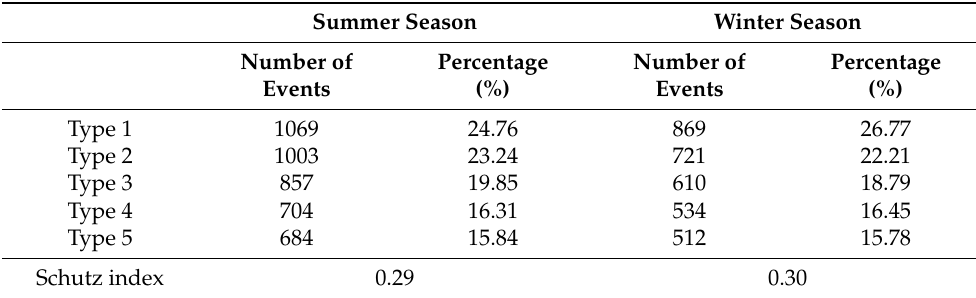
Table 2. Threshold values of the Schutz index as well as the numbers and percentages of Type 1 to Type 5 rainfall